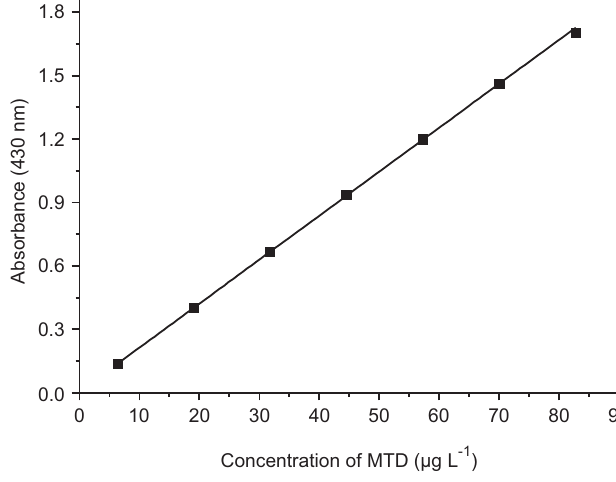
FIGURE 4 - Analytical curve for determination of MTD.